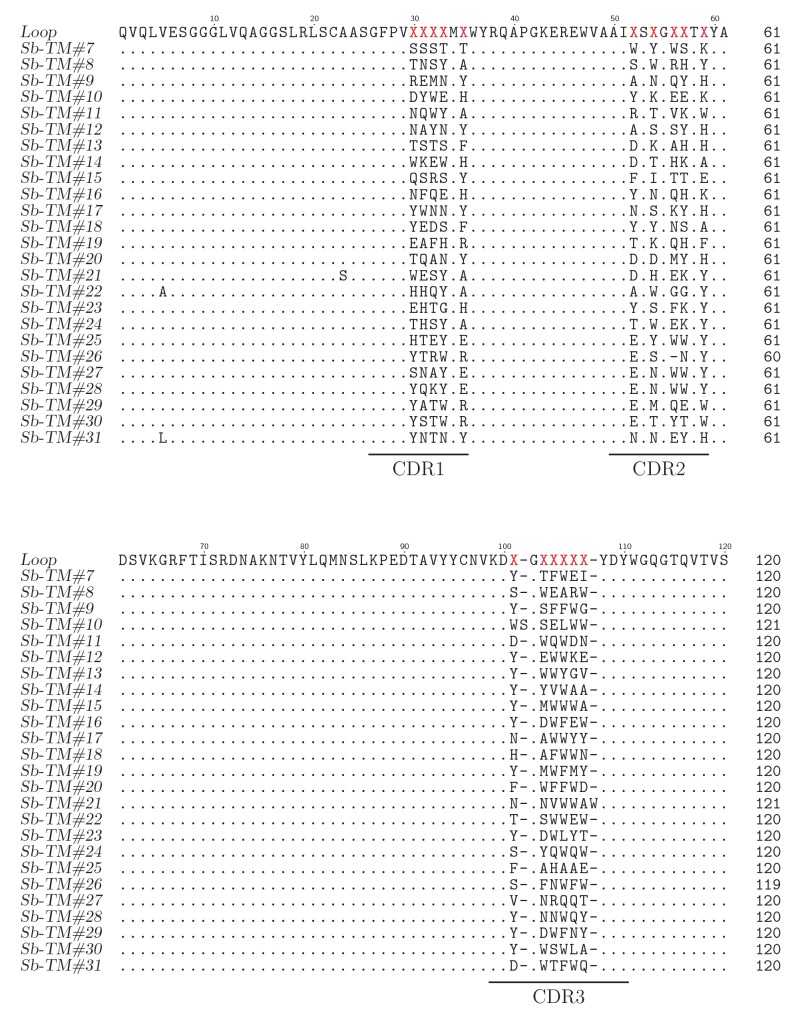
Sequence alignment of loop sybodies raised against TM287/288.